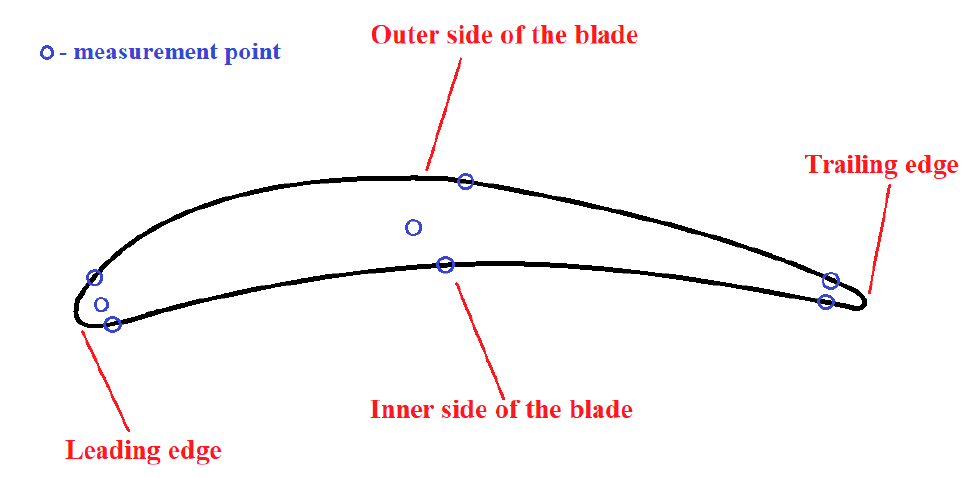
Figure 3. A sketch of a magnified cross-section with the marked measurement locations and geometrical terms for the analyzed blade.